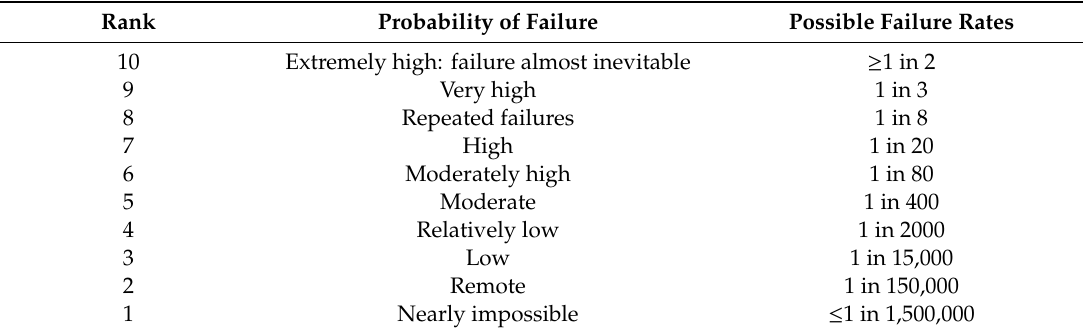
Table 2. Ratings of probability of occurrence of a failure mode